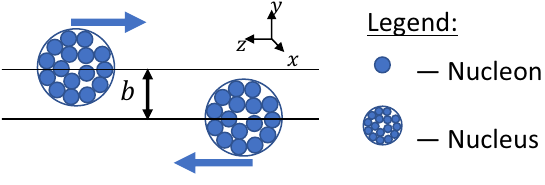
Figure 3. Geometrical model considered. The two colliding nuclei are considered as spheres colliding at a given impact parameter b